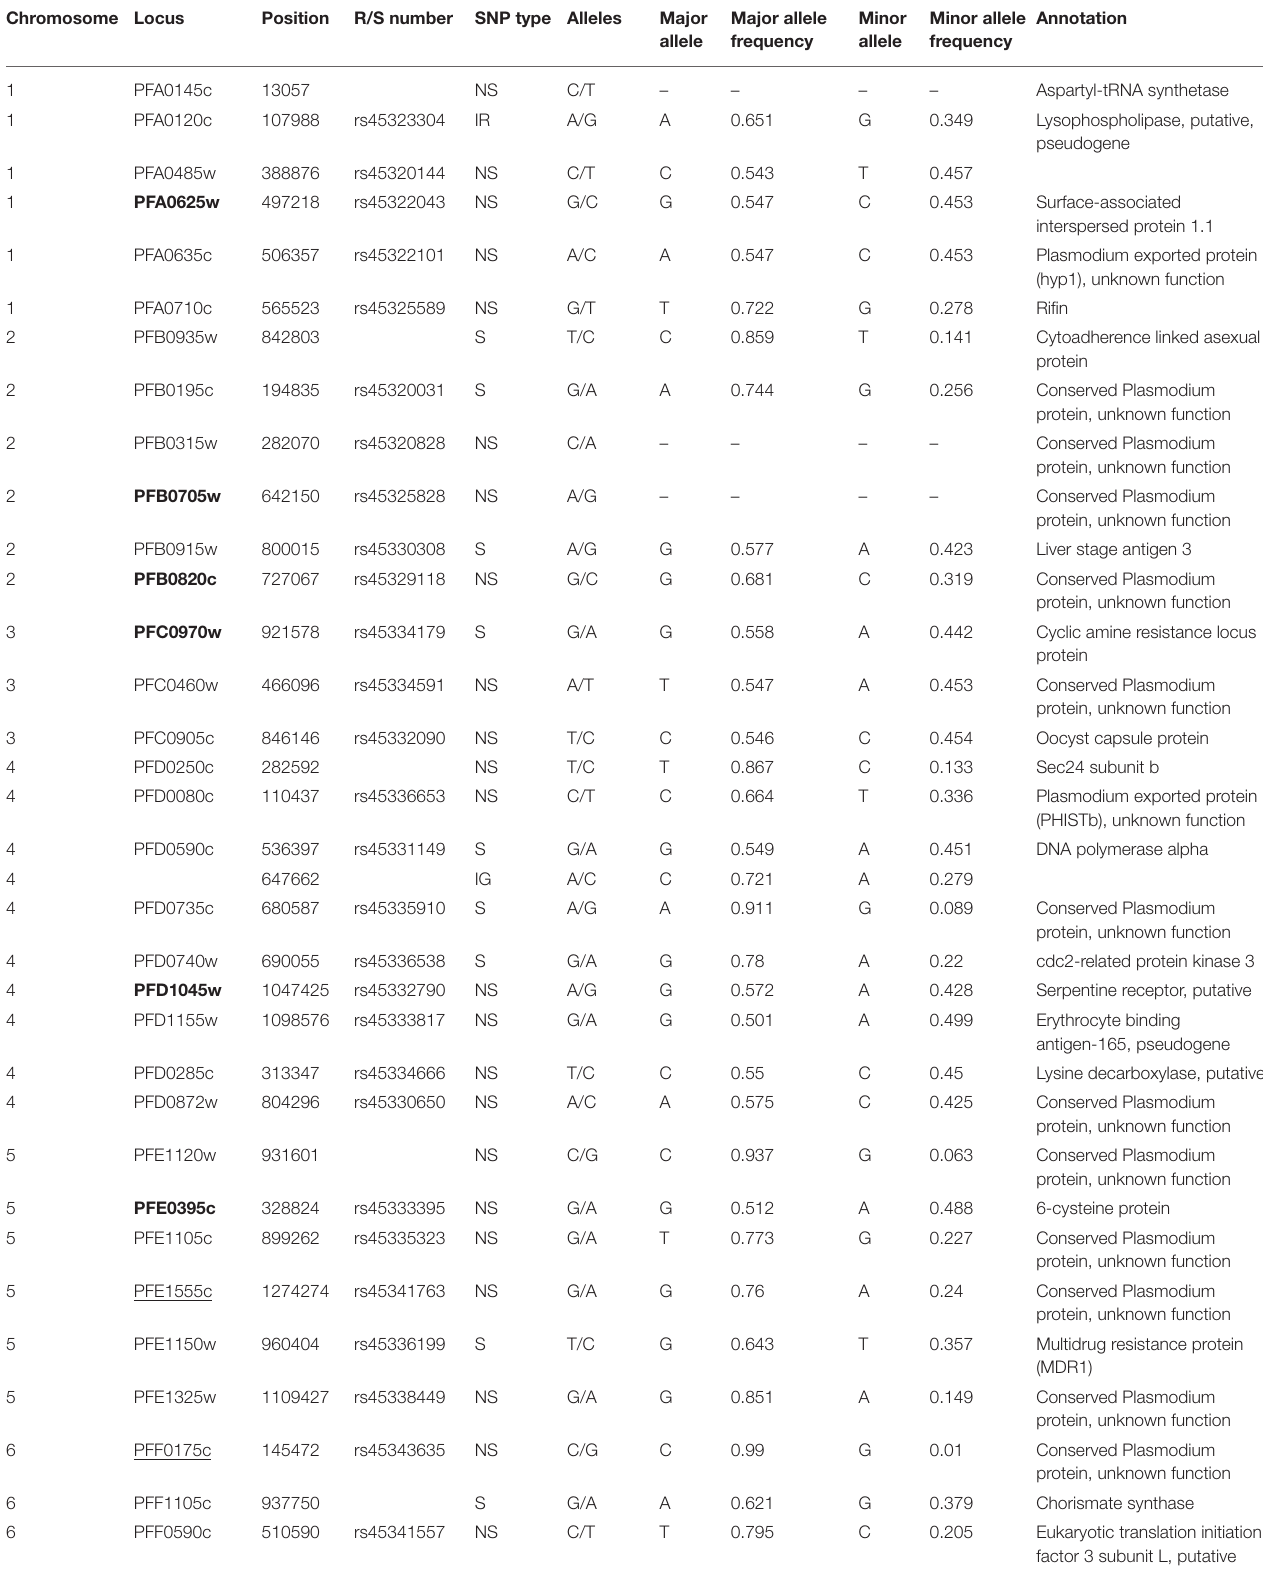
TABLE 1 | Detailed information of the SNPs examined in the present study. Chromosome Locus Position R/S number SNP type